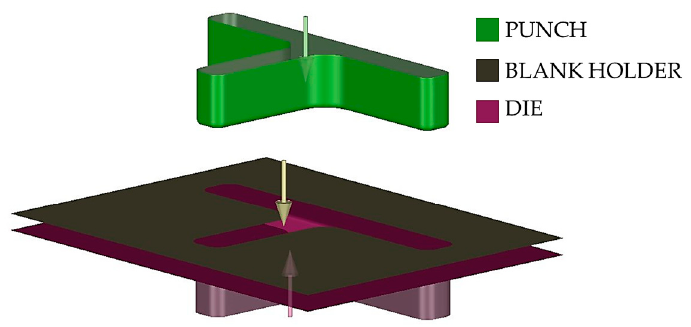
Figure 4. Punch, blank holder, and die modeled in FE